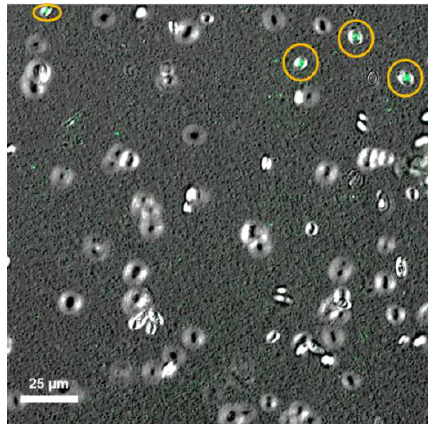
Figure 2. Confocal laser scanning microscopy image of S. boulardii fresh cells stained with propidium iodide, observed to 20× magnification applying a monoparametric detection.